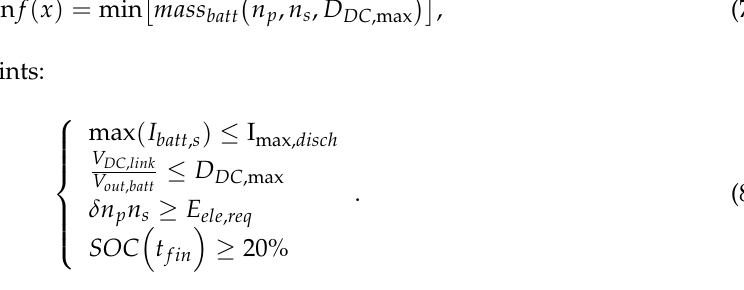
Figure 19. Electrical scheme of the hybrid propulsion system.